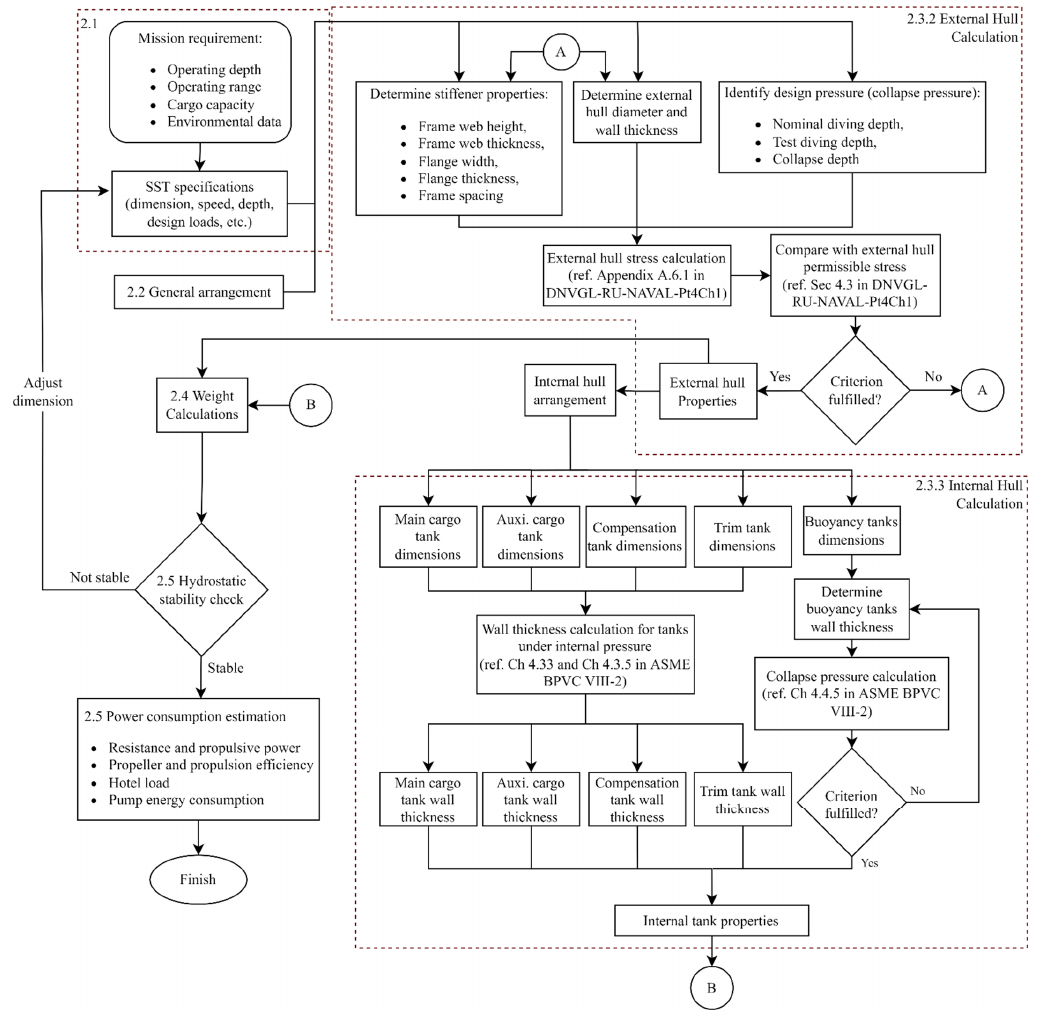
Figure 4. Design flow chart used in SST technical design.